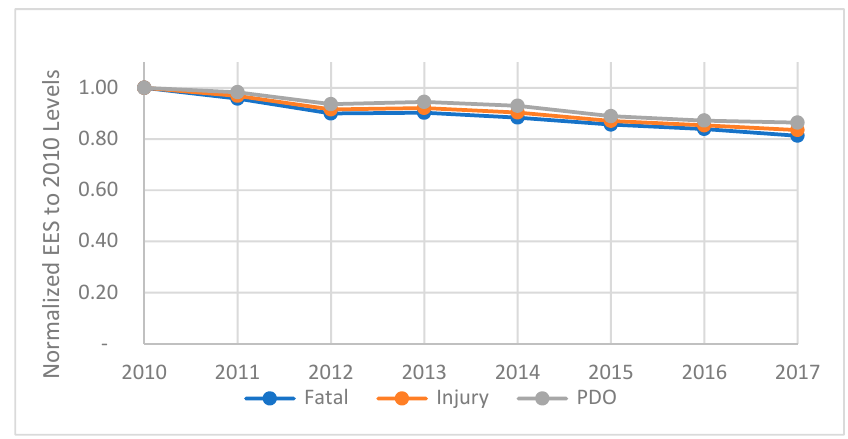
Figure 8. Change of EES per crash.